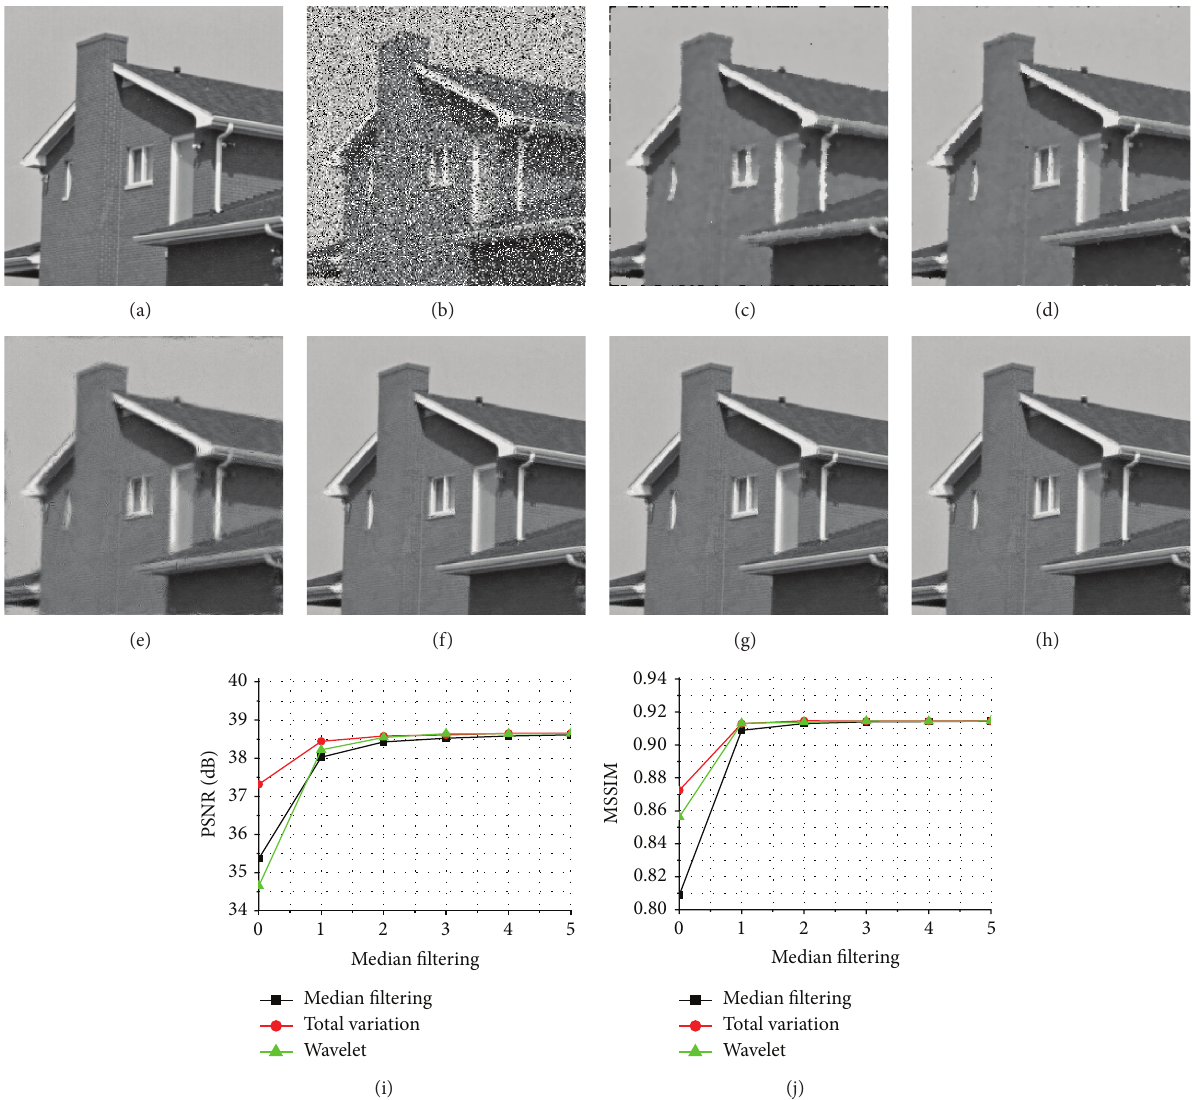
Figure 3: Effect of initial guide images on the denoising performance of the proposed method. (a) Original House image; (b) noisy image with 30% salt-and-pepper noise; (c), (d), and (e) are denoised images using median filtering, total variation, and wavelet, respectively; (f), (g), and (h) are denoised images using the proposed method with (c), (d), and (e) as the initial guide image, respectively; (i) and (j) are the PSNR and MSSIM performance